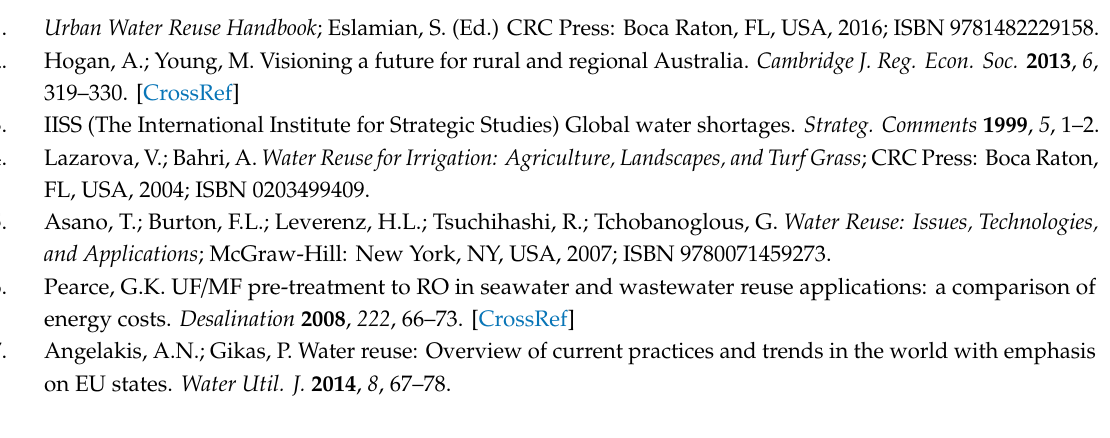
Table S1: Health-based targets for recycled water use in agriculture, Table S2: Water quality for irrigation, Table S3: EPA guideline for agricultural water reuse, Table S4: Water quality for irrigation in California’s regulation, Table S5: The E.U. commission proposal for minimum recycled water quality in order to use in